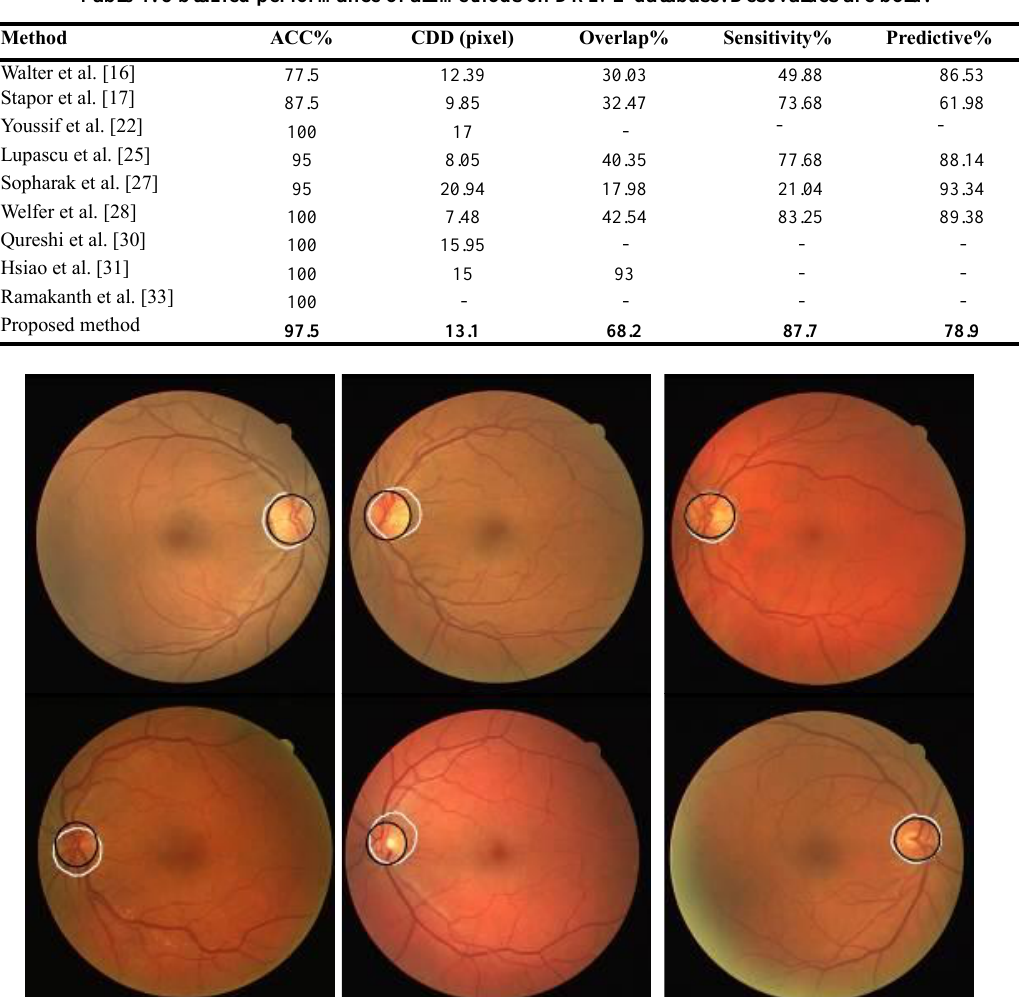
Table 4. Obtained performance of all methods on DRIVE database. Best values are bold.